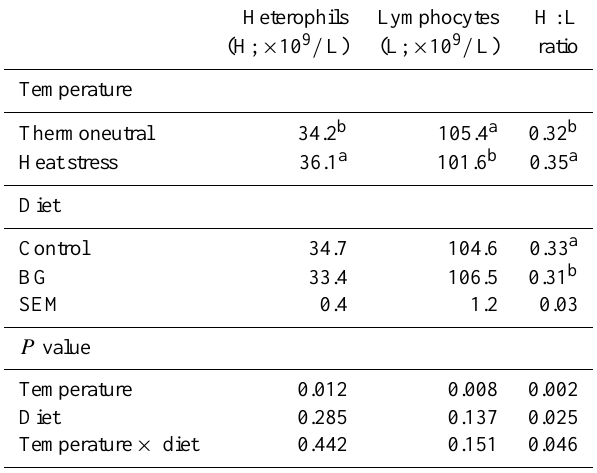
Table 3. Effect of propolis (bee glue; BG) on heterophil and lym- phocyte concentrations and the heterophil to lymphocyte (H:L) ra- tio of broiler chickens subjected to heat challenge ( n = 6).